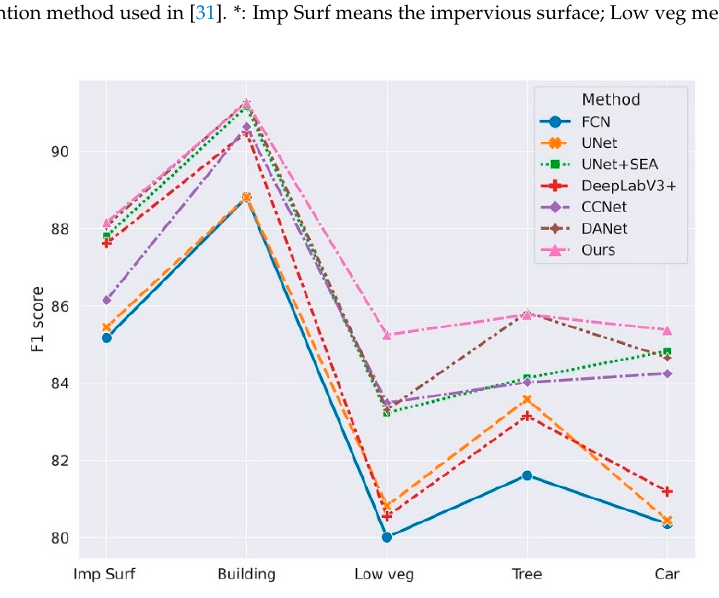
Figure 15. Visualization of comparison study results for Potsdam.